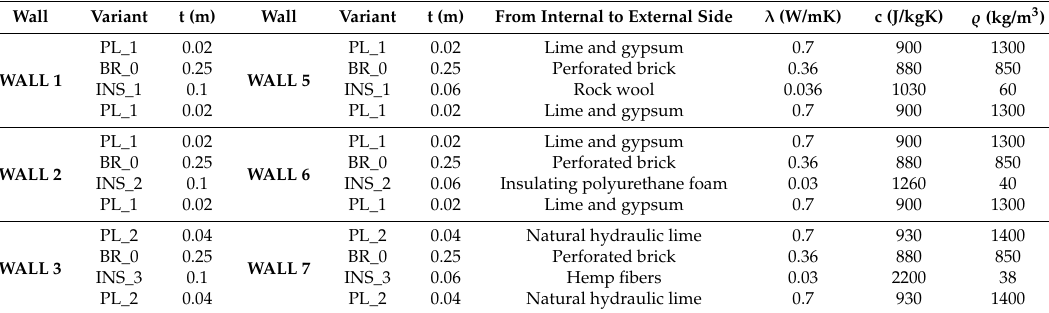
Table 2. Stratigraphy of walls